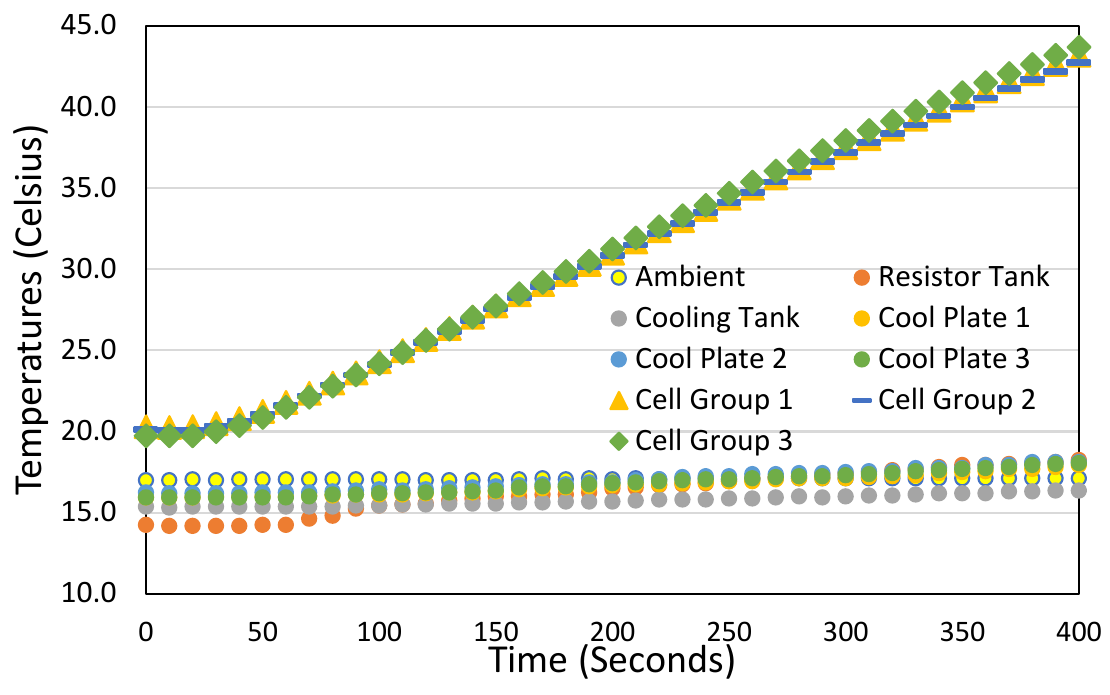
Figure 3. Fifth calibration cycle temperatures during discharge (5C-rate). The chiller was not turned on during the calibration experiment, however, water was flowing through the system with an uncooled reservoir.